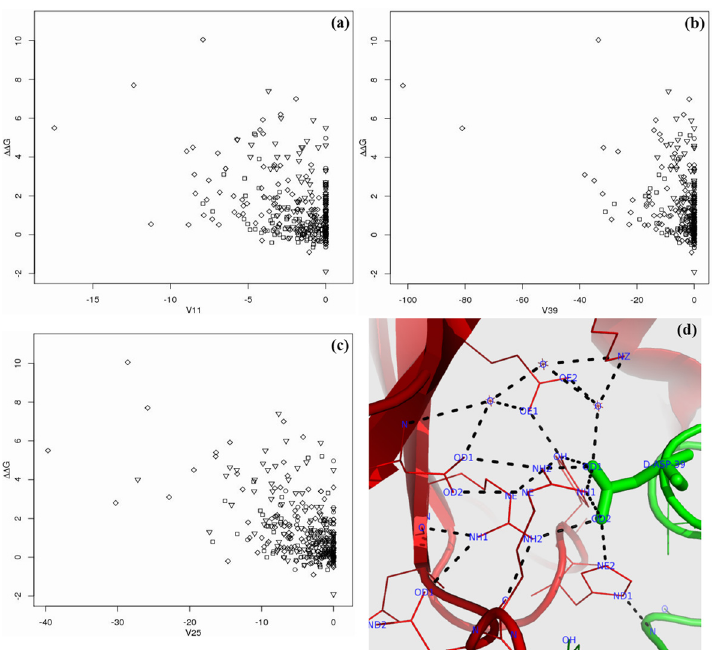
Fig 4. The distribution of three hydrogen-bond features V11 (in (a)), V39 (in (b)) and V25 (in (c)). The definitions of V11, V39 and V25 are listed in Table 5. The importance of V11, V39 and V25 is ranked as 6 th , 7 th and 13 th , respectively, as shown in Fig 2, while the Pearson correlation coefficients of the three features are -0.426, -0.413 and -0.550, respectively, as shown in Table 5. The y-axes denote ΔΔ G . (cid:7) : ILE, VAL, LEU, MET, ALA and GLY; ◻ : CYS, THR, SER, PRO, HIS, GLN and ASN; ♢ : GLU, ASP, LYS and ARG; ! : PHE, TRP and TYR. (d) shows an example of all hydrogen bonds in the neighborhood of the mutation (in ‘ stick ’ view): Asp39 of Chain D (in green) in 1BRS together with the partner protein (Chain A in red). The alanine mutation of Asp39 has ΔΔ G = 7.7kcal/mol and the smallest value of V39. The dashed lines represent potential hydrogen bonds whose acceptors and donors have spatial distance less than 3.5 Å